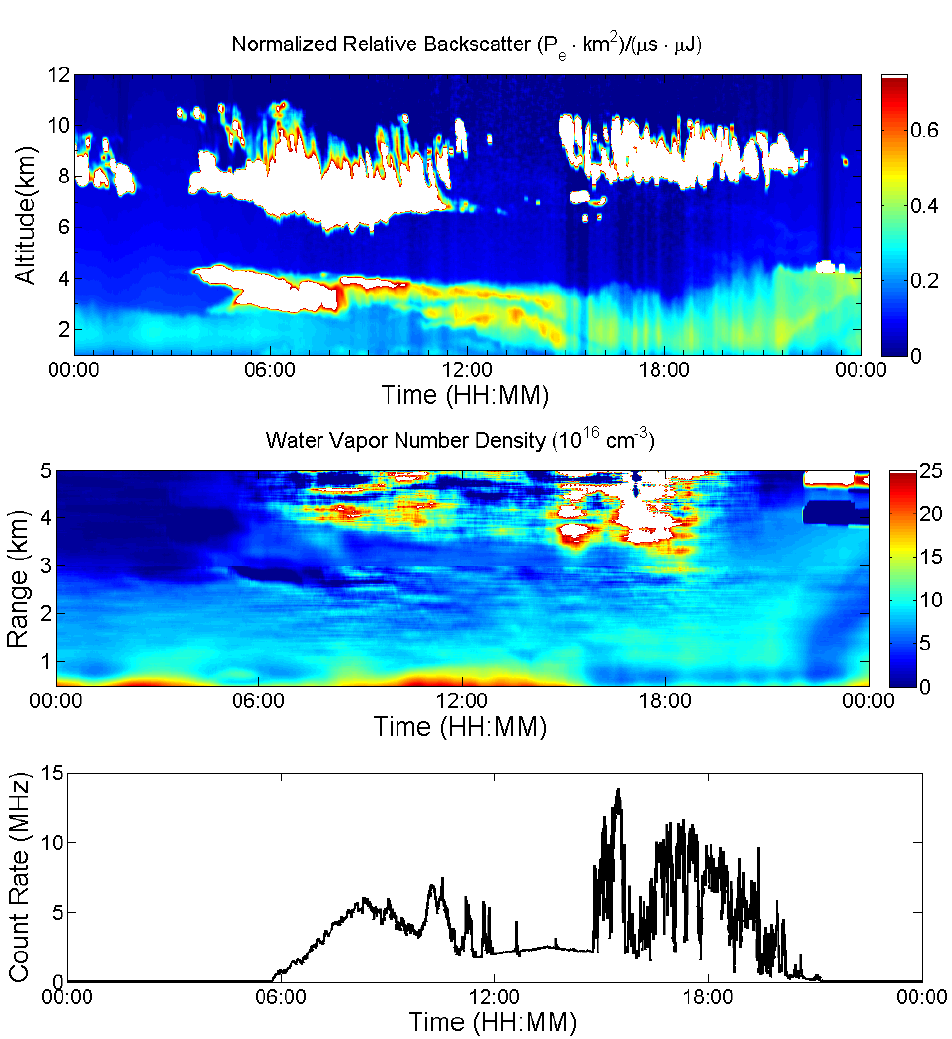
Figure 9. The upper plot shows the normalized relative backscatter as a function of time and range for 24 July 2013, while the middle figure shows the corresponding water vapor number density as a function of range and time. The bottom figure shows the background count rate as a function of time measured using the last fifty ranges bins. Operations during cloudy conditions result in maximum background count rates exceeding 14 MHz and water vapor retrievals during daytime operations can be achieved between 3 and 3.5 km depending on atmospheric